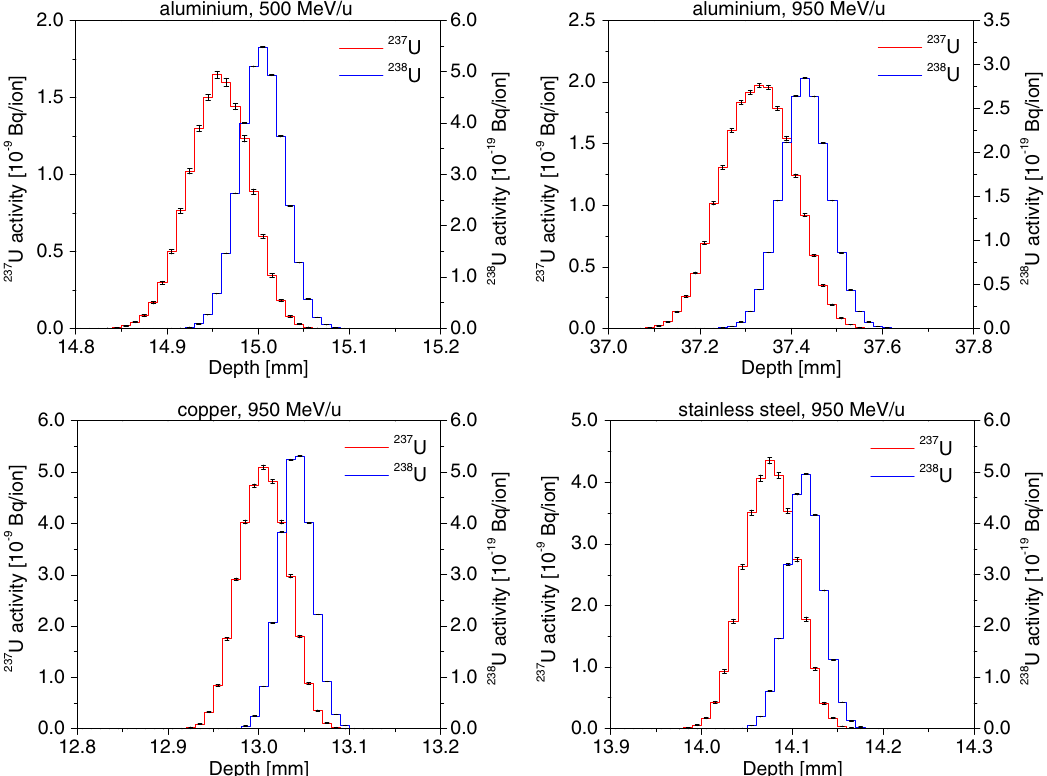
FIG. 2. Depth profiles of the residual activity of the 238 U primary ions and the 237 U fragments in aluminum, copper, and stainless- steel target simulated using FLUKA2011.2.3 . The initial energy of the primary ions was 500 and 950 MeV = u . The depth resolution of simulated profiles is 10 (cid:2) m (aluminum irradiated with 500 MeV = u beam, copper irradiated with 950 MeV = u beam, and stainless steel irradiated with 950 MeV = u beam) and 20 (cid:2) m (aluminum irradiated with 950 MeV = u beam).